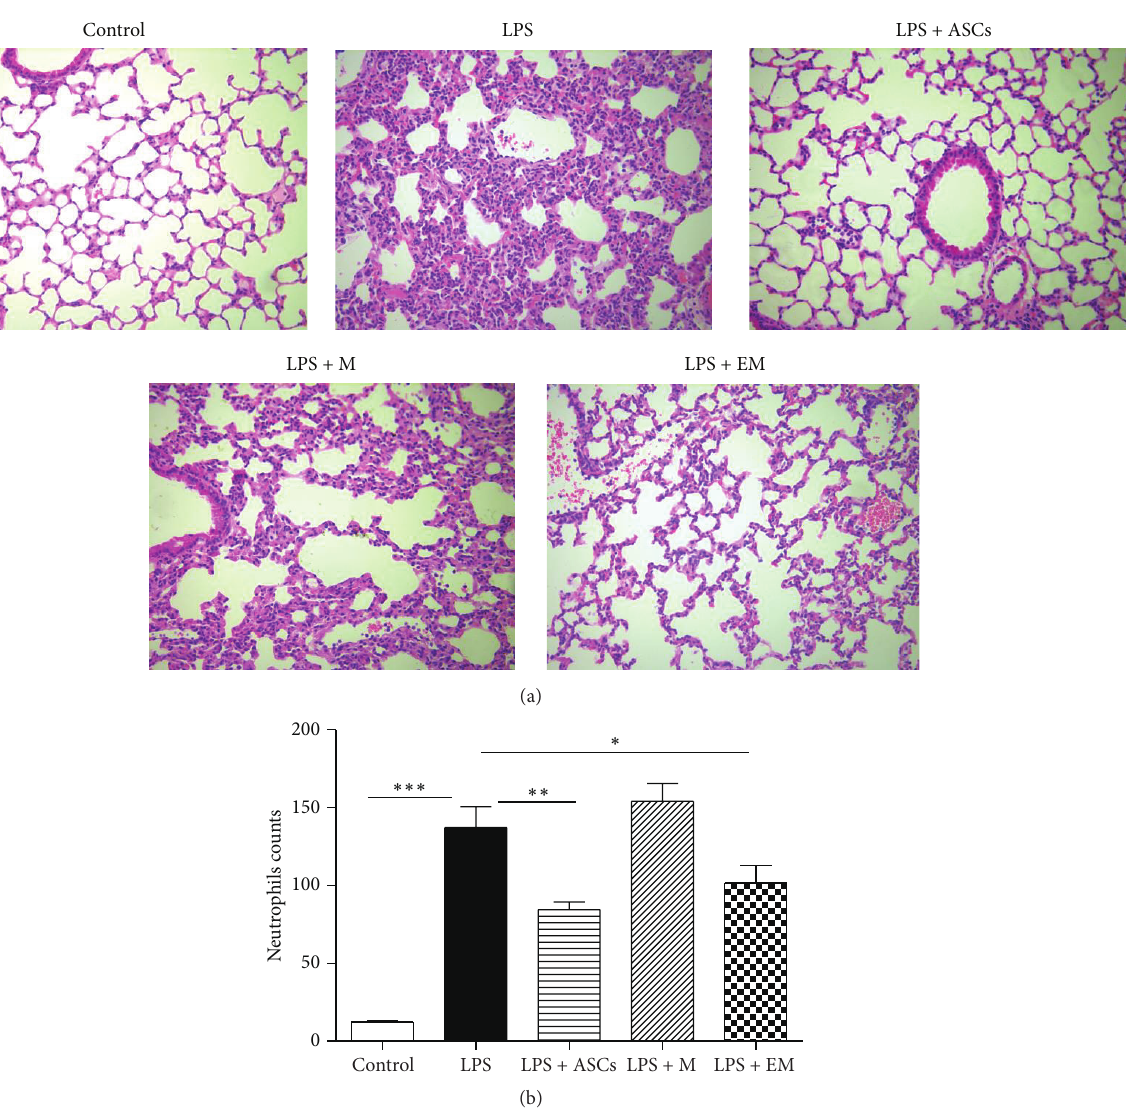
Figure 1: Educated macrophages (EM) decrease LPS-induced lung inflammation. Mice were allocated and received the following treatment: control, LPS, LPS + ASCs, LPS + macrophages (M), and LPS + EM. Animals were sacrificed before and at 6, 24, and 48 h after LPS or PBS treatment. (a) Lungs were fixed in paraformaldehyde. Lung sections were stained with H&E and visualized at × 200 magnification. (b) Quantification of neutrophils per high-power field on lung sections stained with H&E. All data are expressed as mean ± SEM. ∗ 𝑝 < 0.05 ; ∗∗ 𝑝 < 0.01 ; and ∗∗∗ 𝑝 < 0.001